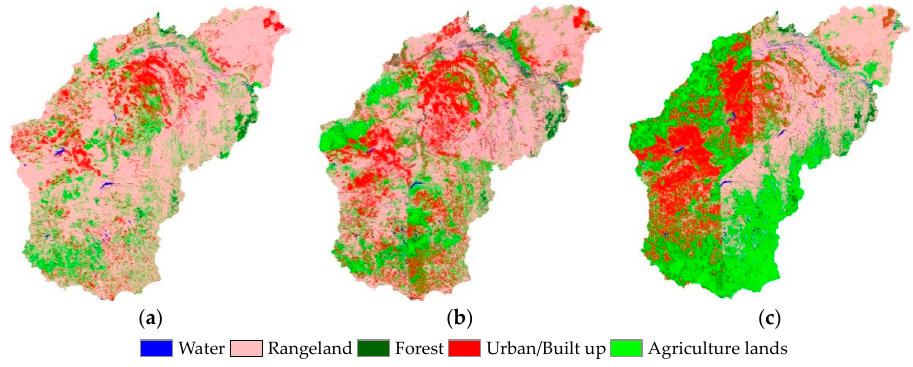
Figure 2. Land use maps for ( a ) 2000, ( b ) 2007 and ( c ) 2013 in the Olifants Basin. Table 1. Details of Landsat 7 Enhanced Thematic Mapper Plus (ETM+) Images used for classification.